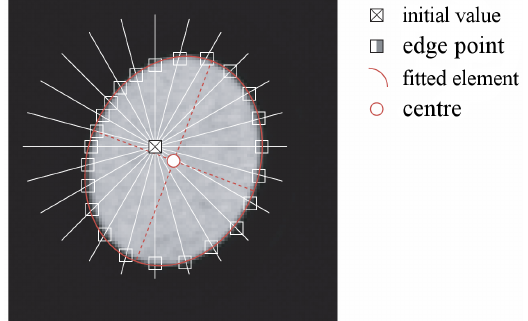
Figure 1. Principle of the star operator (Luhmann et al. , 2006) 2.1.4